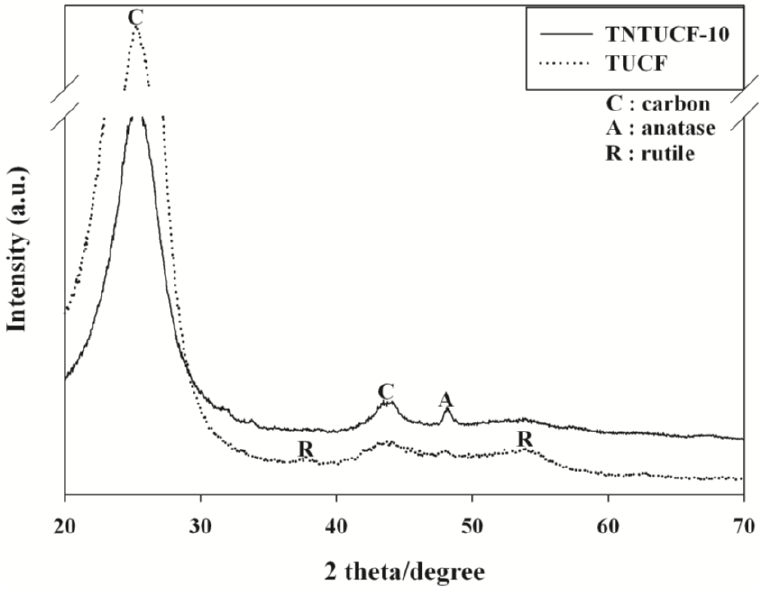
Figure 4. X-ray diffraction (XRD) patterns of a representative TNTUCF (TNTUCF-10) and